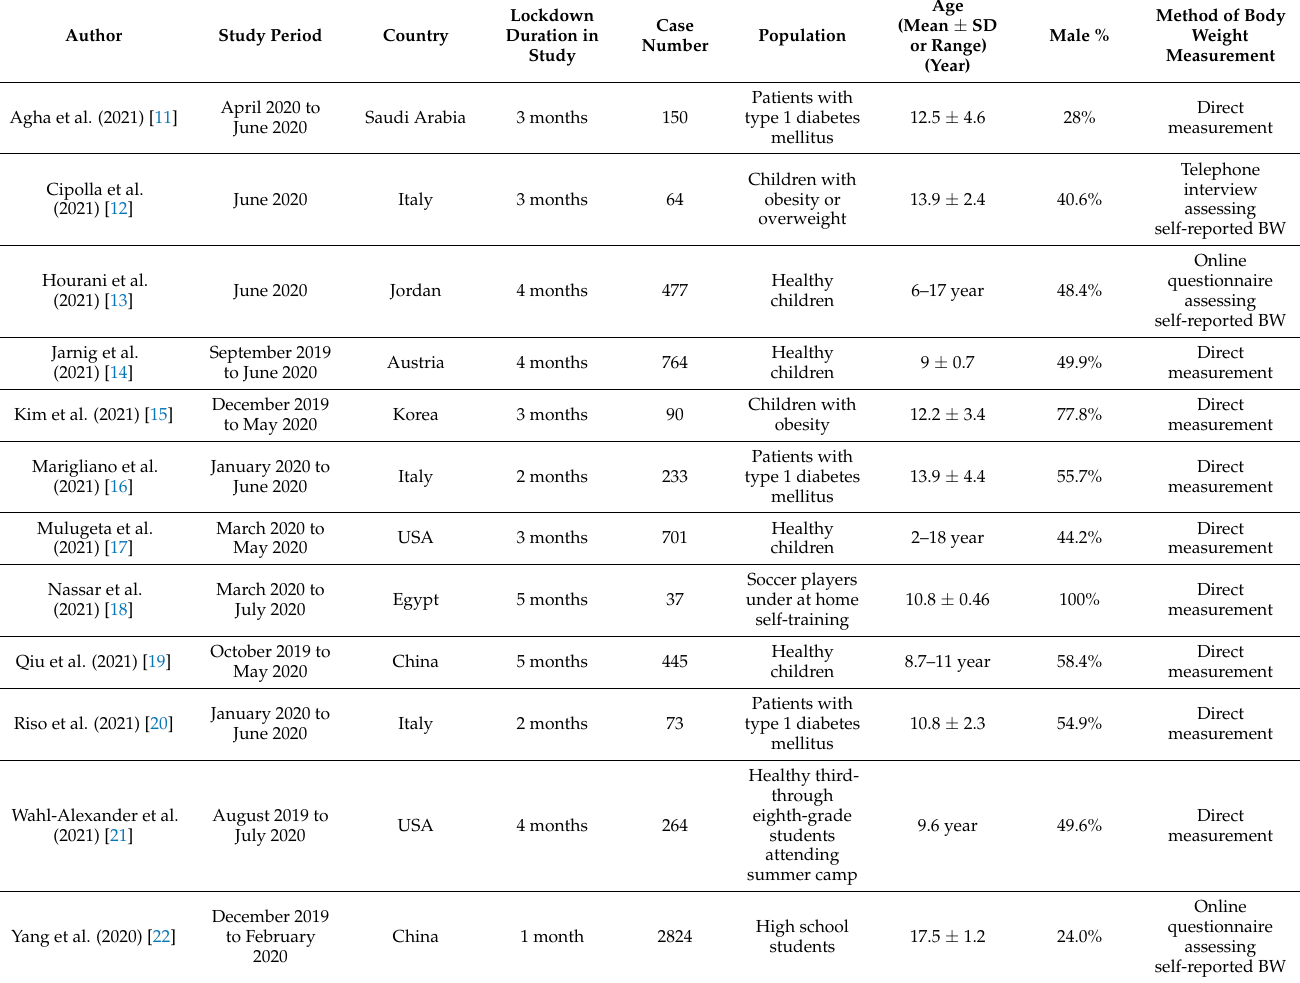
Table 1. Characteristics of the included studies assessing the relationship between lockdown and body